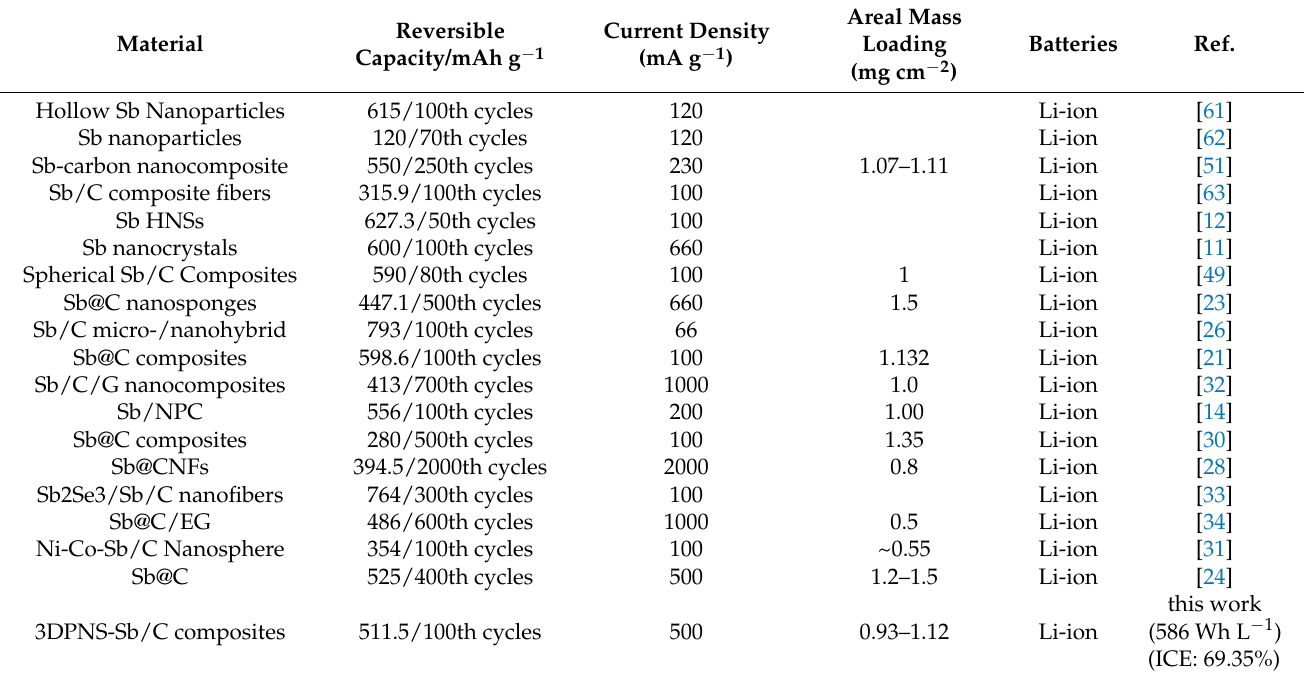
Table 1. Contrast of the electrochemical properties of 3DPNS-Sb/C composites (this work) and various reported Sb-C as anodes for LIBs.